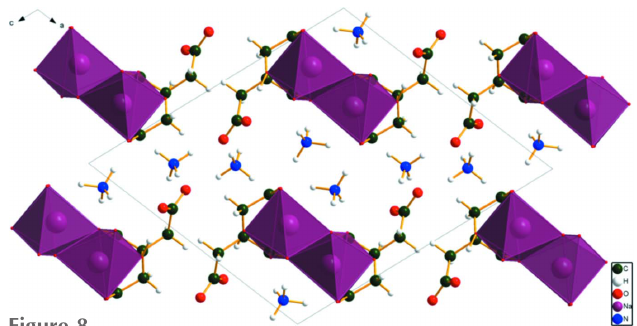
Figure 8 The crystal structure of (II), viewed down [010].